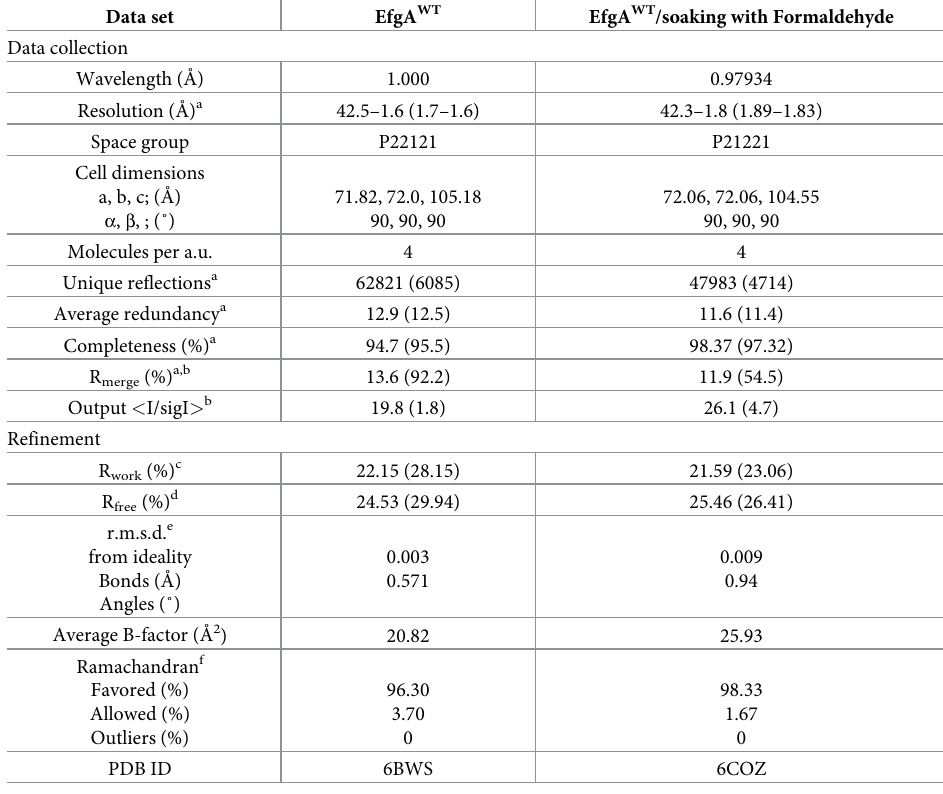
Table 2. Data collection and refinement